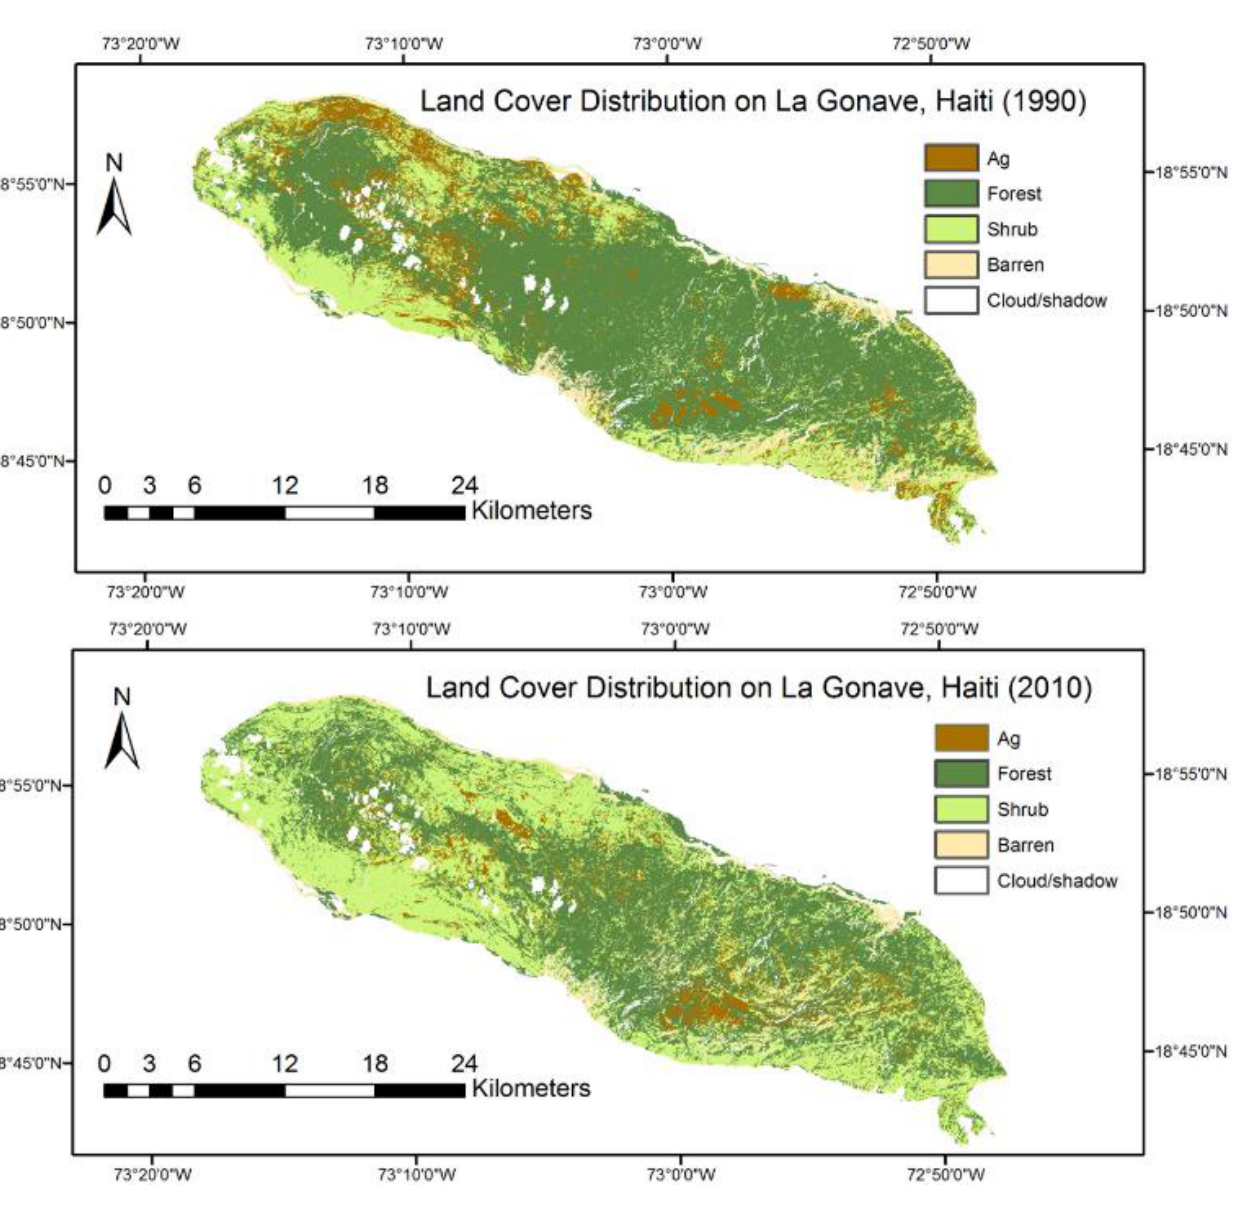
Figure 2. Land cover classification maps for La Gonave, Haiti, 1990 and